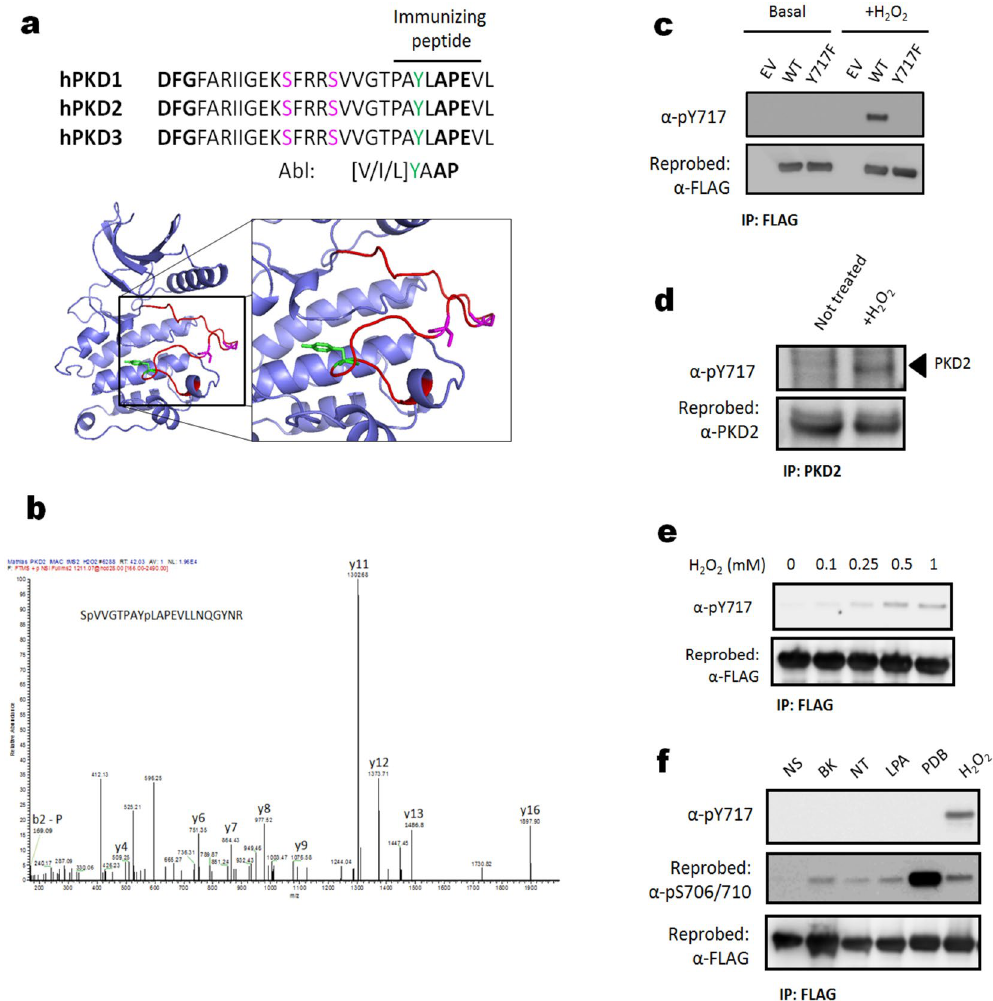
Figure 1. Identification of PKD2 Tyr-717 phosphorylation during oxidative stress. ( a ) Upper panel: alignment of the PKD1/2/3 activation segment. Activation loop serine residues are denoted in purple, the identified pTyr-residue in green. The borders of the activation segment are indicated in bold. Lower panel: position of the activation loop Ser residues and Tyr residue in a PKD2 homology model (generated by the Phyre2 server). ( b ) Mass spectrometry based identification of the p-Tyr717 containing peptide following oxidative stress. ( c ) Tyr- 717 phosphorylation after oxidative stress is detected by a PSSA. HEK293 cells were transfected with wild type (WT) PKD2 or an Y717F mutant. 48 h after transfection, cells were stimulated with H 2 O 2 (10 mM, 10 min) and PKD2 was precipitated from the cells using FLAG antibody. Phosphorylation of Tyr-717 was assessed using the home-made PSSA. Western blots were cropped for clarity; uncropped images can be found in Supplementary Fig. S4. ( d ) Phosphorylation of endogenous PKD2 following oxidative stress. HEK293 cells were stimulated with H 2 O 2 (10 mM, 10 min) and PKD2 was precipitated from the cells using a PKD2 antibody. Phosphorylation of Tyr-717 was assessed using the home-made PSSA. N.S.: non-stimulated cells. Western blots were cropped for clarity; uncropped images can be found in Supplementary Fig. S5. ( e ) Sub-millimolar doses of H 2 O 2 elicit Tyr-717 phosphorylation. HEK293 cells were transfected with wild type (WT) PKD2. 48 h after transfection, cells were stimulated with H 2 O 2 at the indicated concentrations for 10 min and PKD2 was precipitated from the cells using FLAG antibody. Phosphorylation of Tyr-717 was assessed using the home-made PSSA. Western blots were cropped for clarity; uncropped images can be found in Supplementary Fig. S6. ( f ) Tyr-717 phosphorylation is not observed in classical PKD activation by GPCRs or phorbol-12,13-dibutyrate (PDB). HEK293 cells were transfected with wild type (WT) PKD2. 48 h after transfection, cells were serum starved for 6 h prior to stimulation with bradykinin (BK; 1 µ M, 5 min), neurotensin (NT; 1 µ M, 10 min), Lysophosphatidic acid (LPA; 10 µ M, 5 min), PDB (500 nM, 15 min) or H 2 O 2 (10 mM, 10 min). FLAG immunoprecipitates were subjected to western blot and probed with the indicated antibodies. Western blots were cropped for clarity; uncropped images can be found in Supplementary Fig.